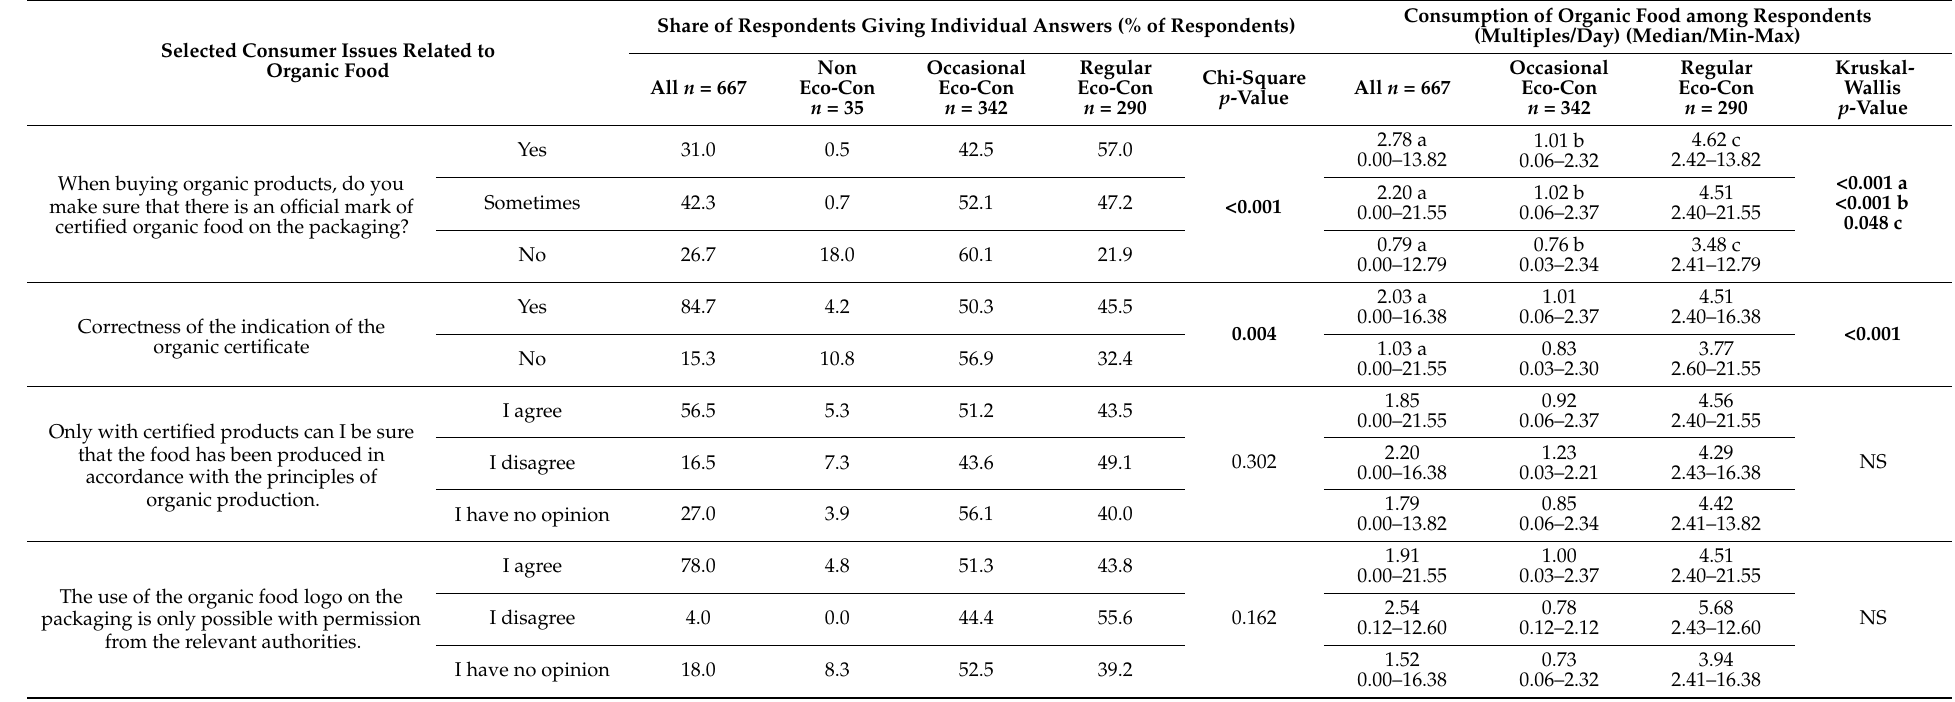
Table 7. Relationship between knowledge of selected consumer issues related to organic food and the level of organic food